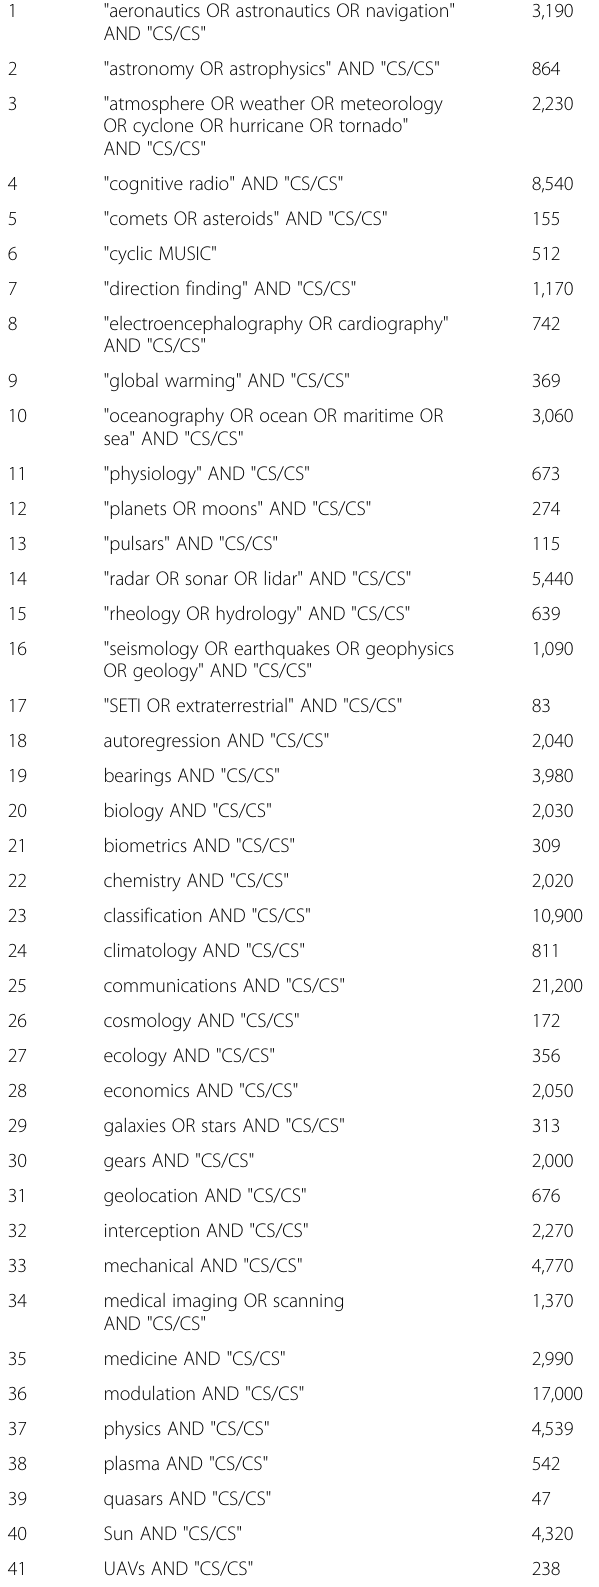
Table 1 Nearly Distinct Application Areas